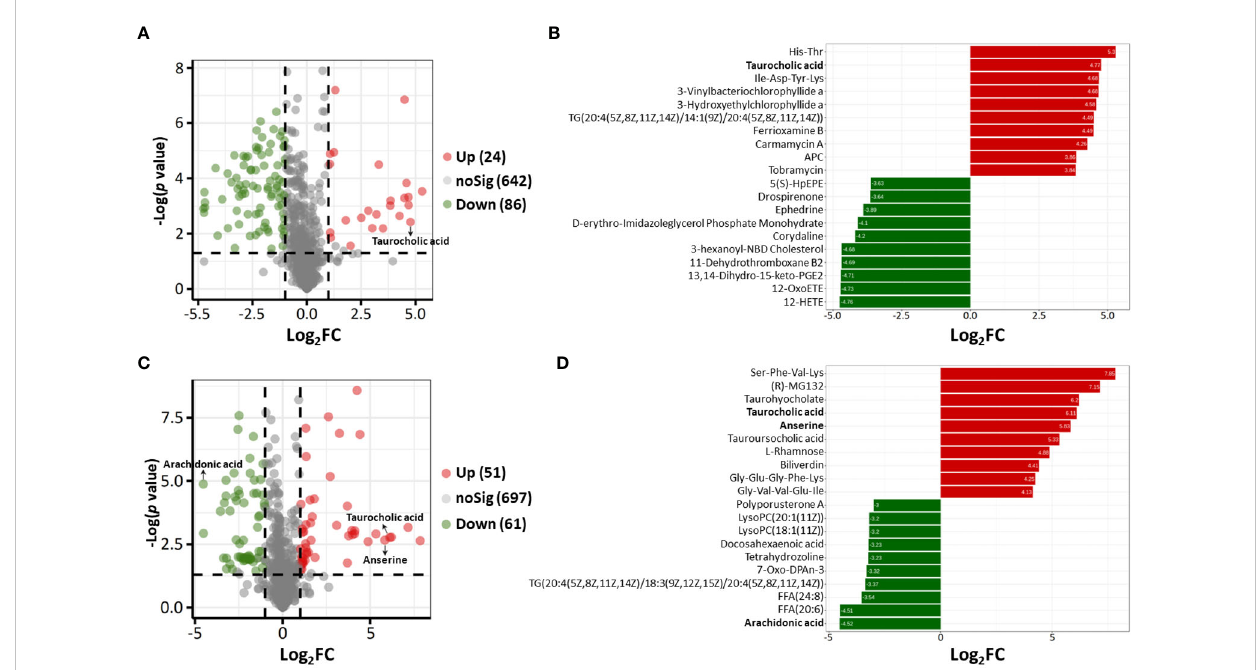
FIGURE 4 (A, C) Volcano plots showing differential metabolites between the acutely infected group (AI) and the noninfected group (Ctrl) in ESI − mode (A) and in ESI+ mode (C) . Each dot represents a metabolite; the red dots represent signi fi cantly upregulated metabolites, and the green dots represent signi fi cantly downregulated metabolites. (B, D) Linear discriminant analysis (LDA) results showing the top 40 enriched metabolites that were signi fi cantly upregulated (red) or downregulated (green) between the AI and Ctrl groups in ESI − mode (B) and in ESI+ mode (D) .